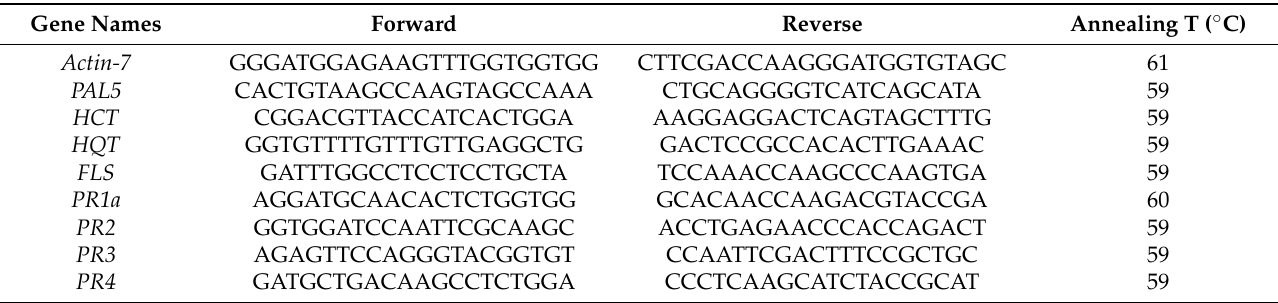
Table 1. Primer sequences used in PCR